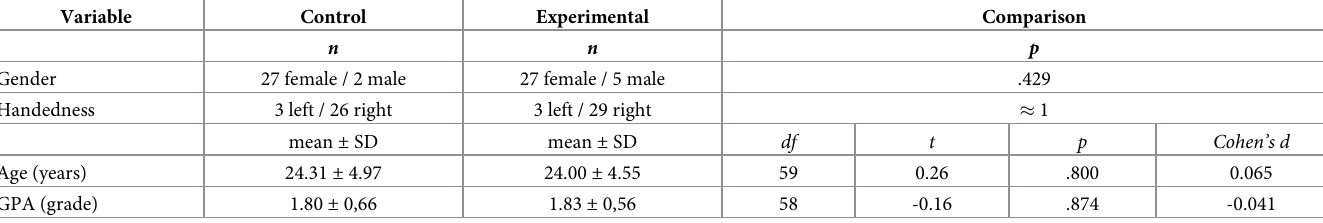
Table 1. Participant